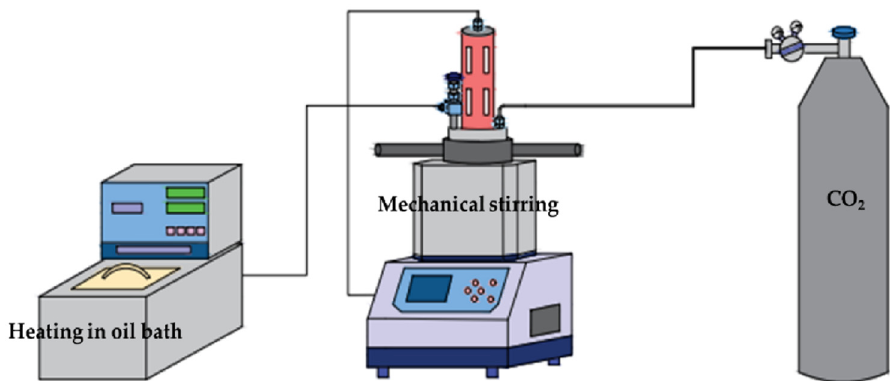
Figure 3. Schematic diagram of experimental set-up for carbonation of AOD slag.